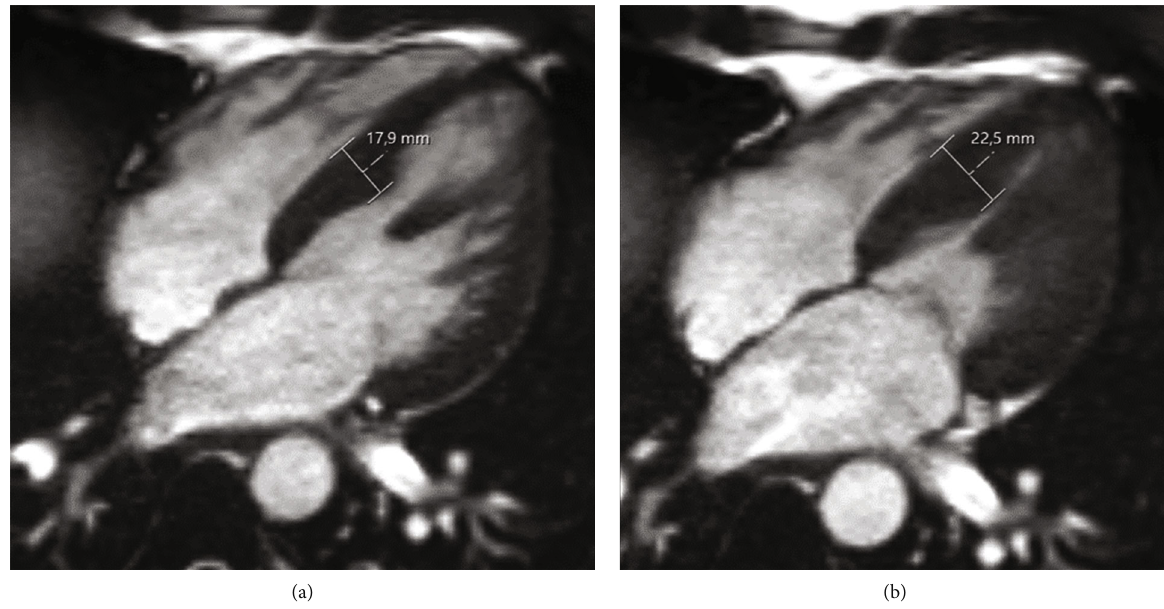
Figure 2: Cardiac MRI of the patient ’ s brother (1.5 Tesla, cine sequence). (a) End-diastolic septal myocardial hypertrophy with maximum measured septum thickness of 17.9mm. (b) End systolic septal myocardial hypertrophy with maximum measured septum thickness of